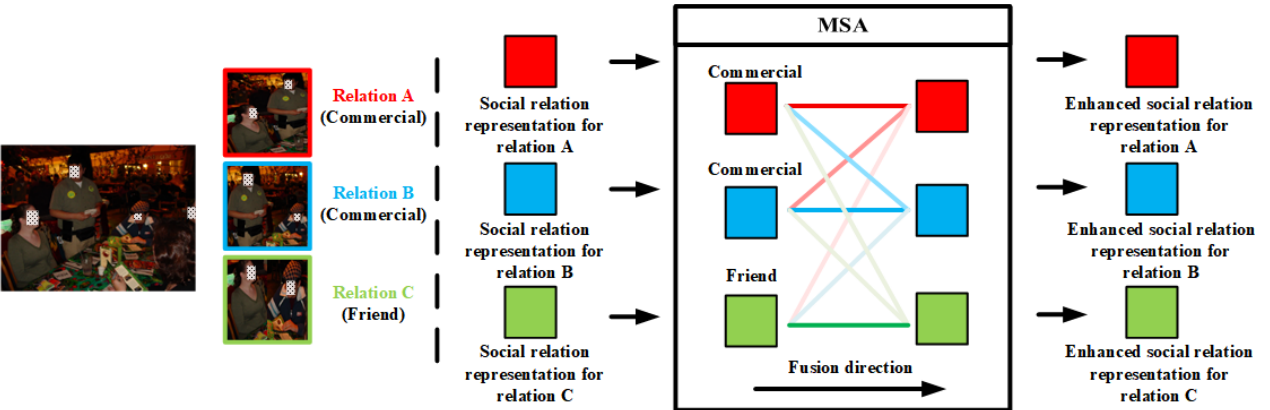
Figure 5. Inter-TRM module. Note that the stack transformer structures are intentionally omitted here for brevity and an intuitive understanding of the